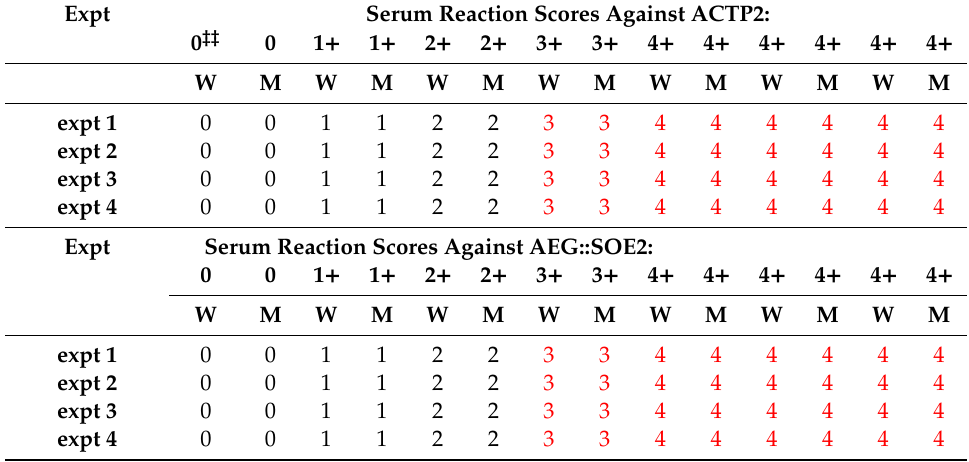
Table 2. Testing by ELISA of women and men sera of di ff erent positive to negative (P / N) ‡‡ 0 to 4 + scores. Expt Serum Reaction Scores Against ACTP2: